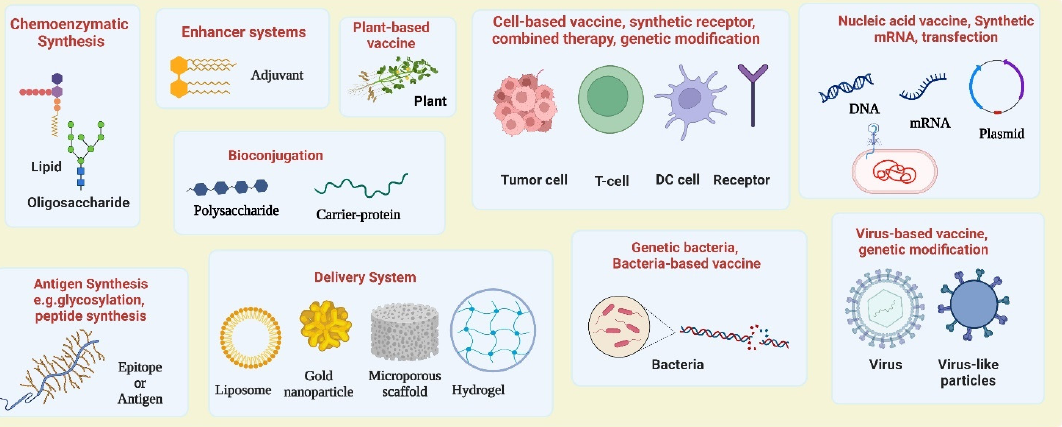
Figure 5. A brief summary of current chemical and synthetic biology approaches for developing cancer vaccines. Abbreviations: DC, dendritic